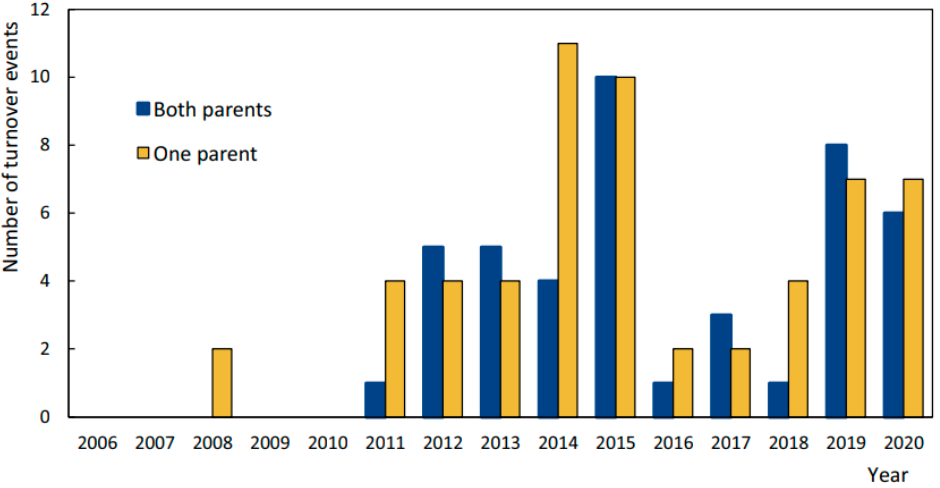
Figure 3. Number of turnover events estimated from 11 microsatellite loci of both (blue bars) or one parent (yellow bars) each year from 2006 to 2020.